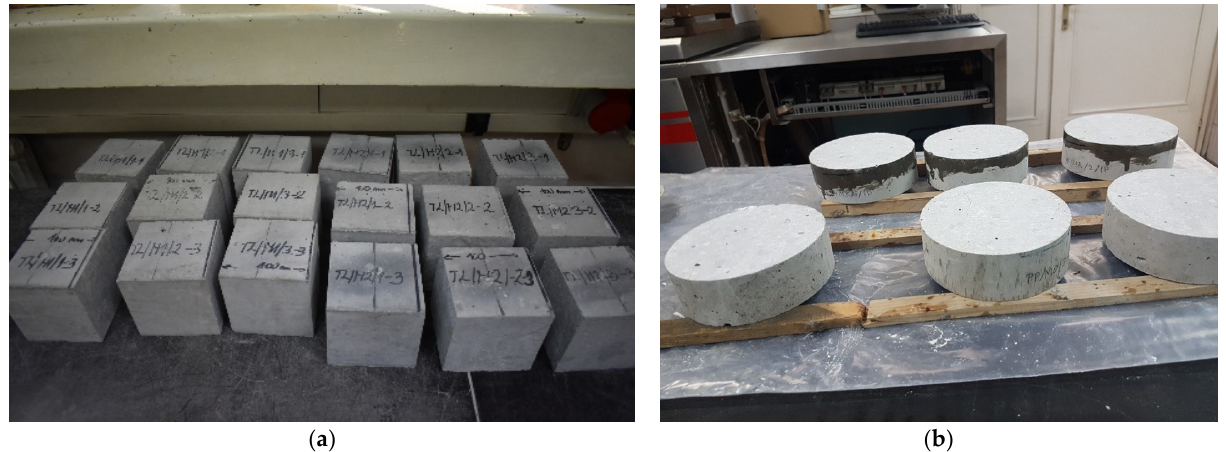
Figure 1. Preparation of samples for testing. ( a ) Cubes sawn from concrete prisms from the M1 and M2 mixes. ( b ) Coating of samples for capillary absorption measurement with epoxy